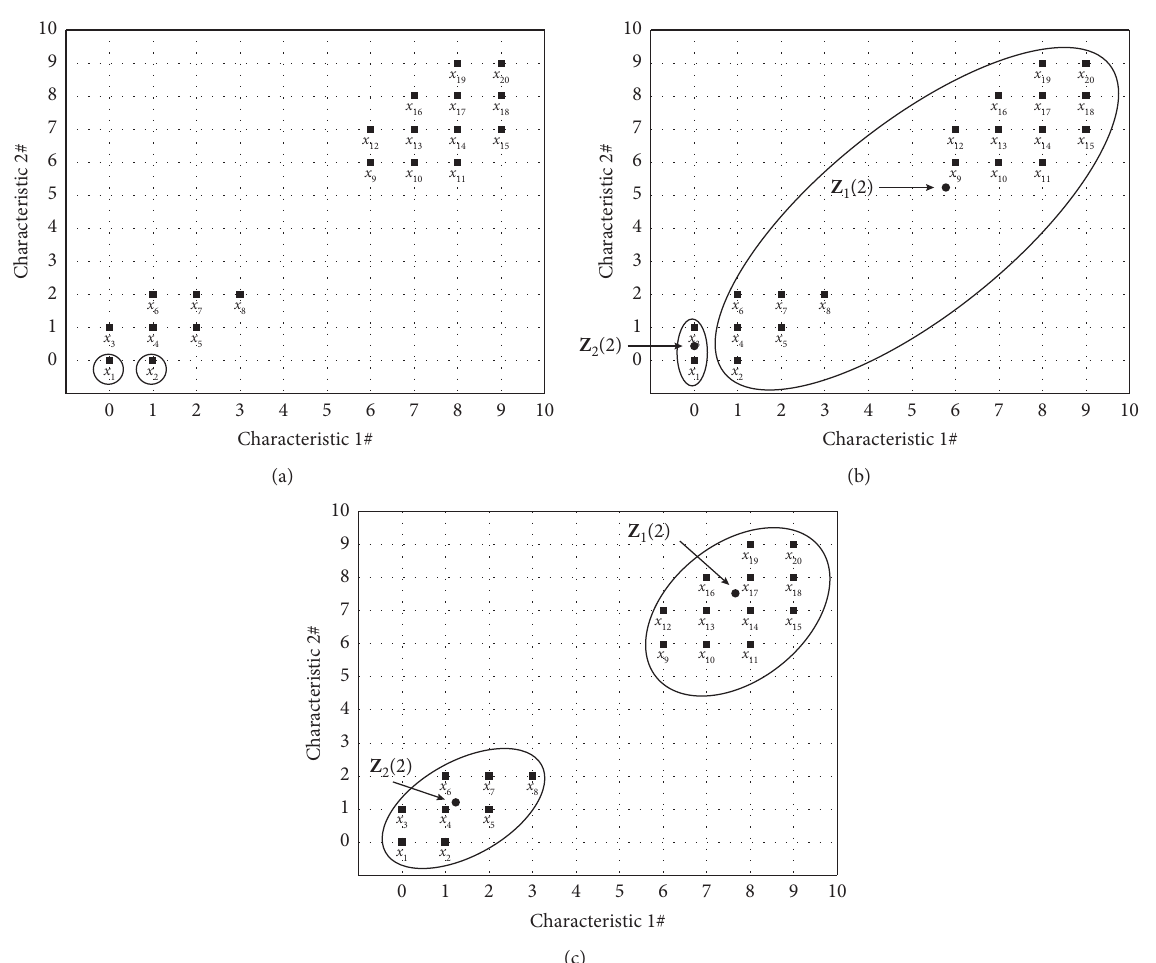
Figure 14: Schematic diagram of K -means algorithm: (a) set the initial cluster center; (b) establish a new cluster center; (c) determine the clustering results.